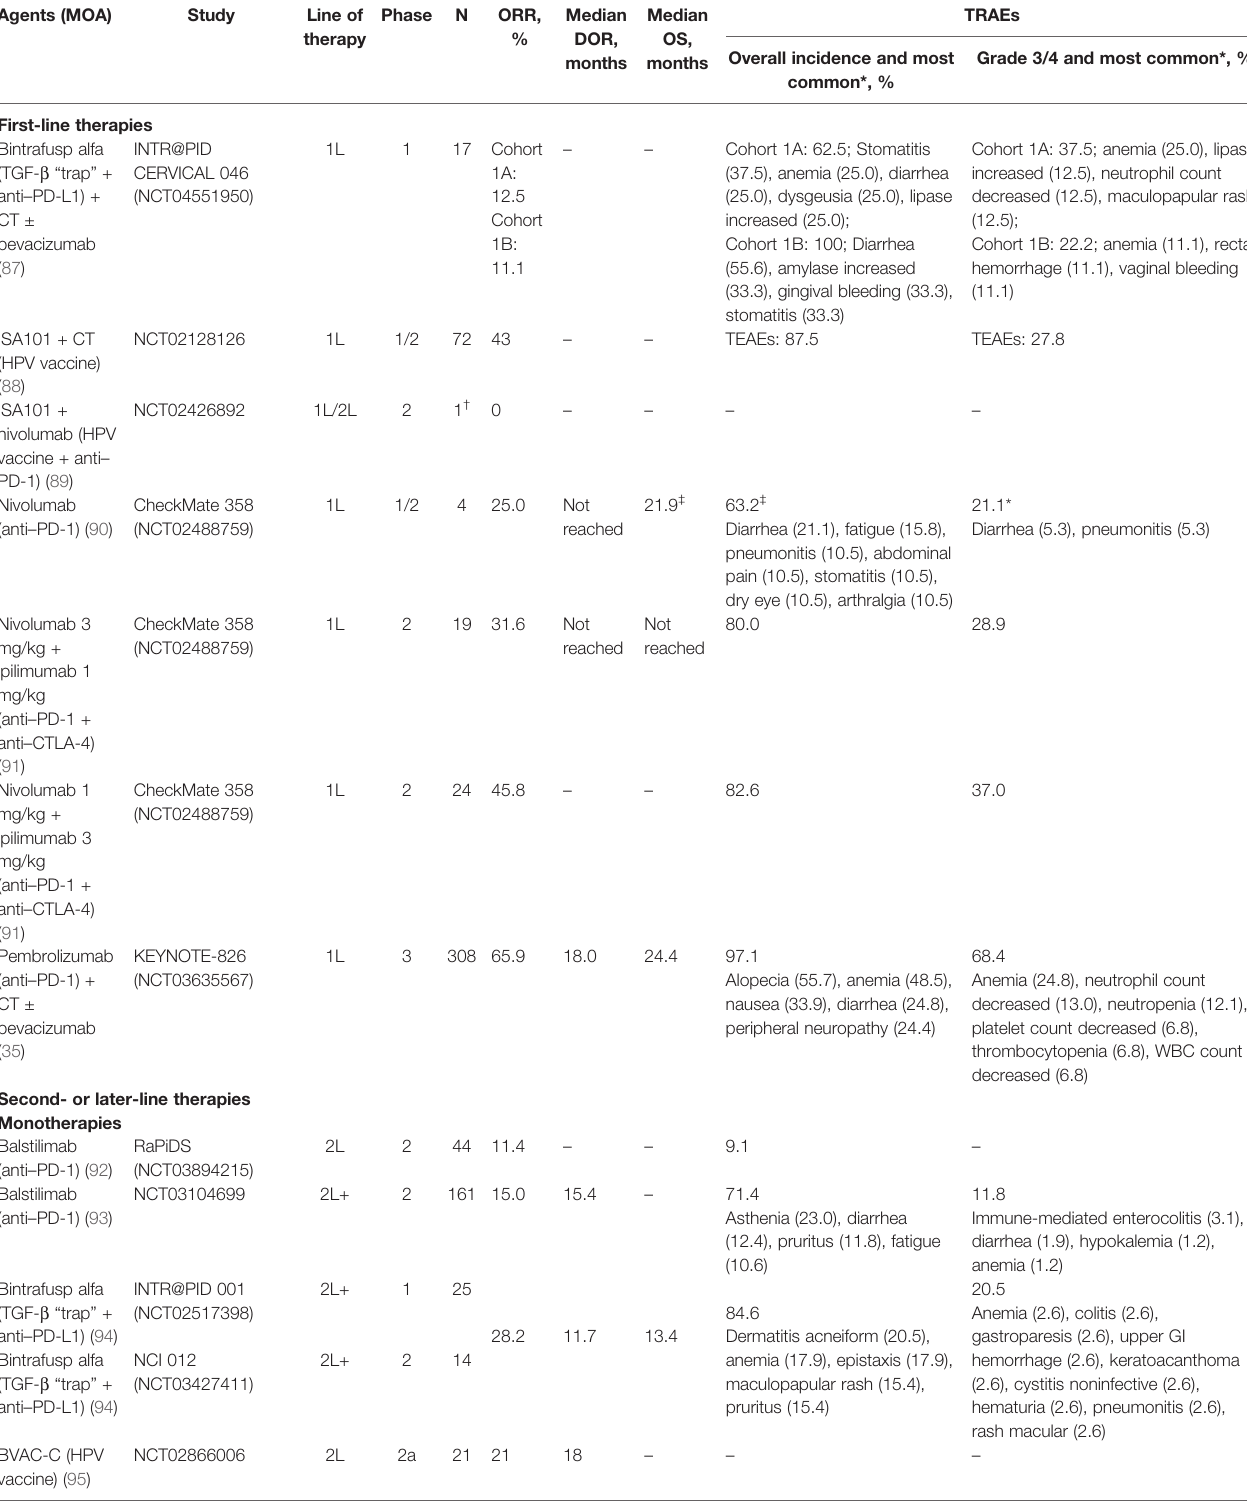
TABLE 1 | Ef fi cacy and safety of immunotherapy agents as monotherapy or in combination with other therapies in cervical cancers. Agents